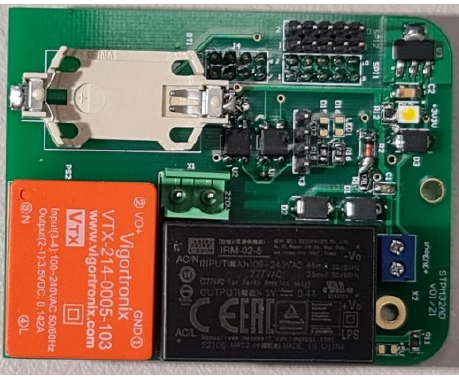
LDO regulator—low-dropout regulator).